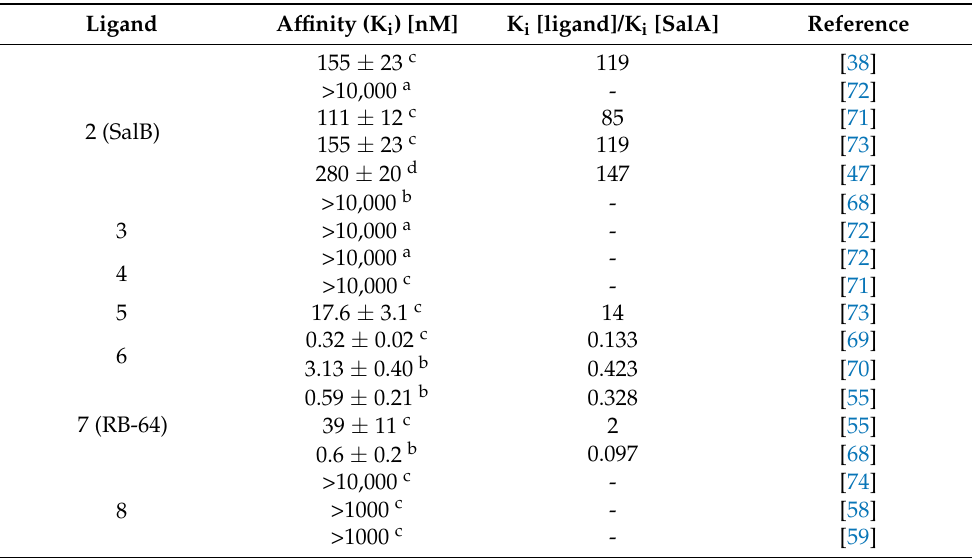
Table 4. Experimental data for binding of SalA and all analogs discussed within this section measured in radioligand binding